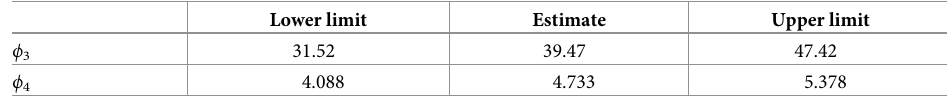
Table 2. Confidence intervals at 95% for fixed effects of the model